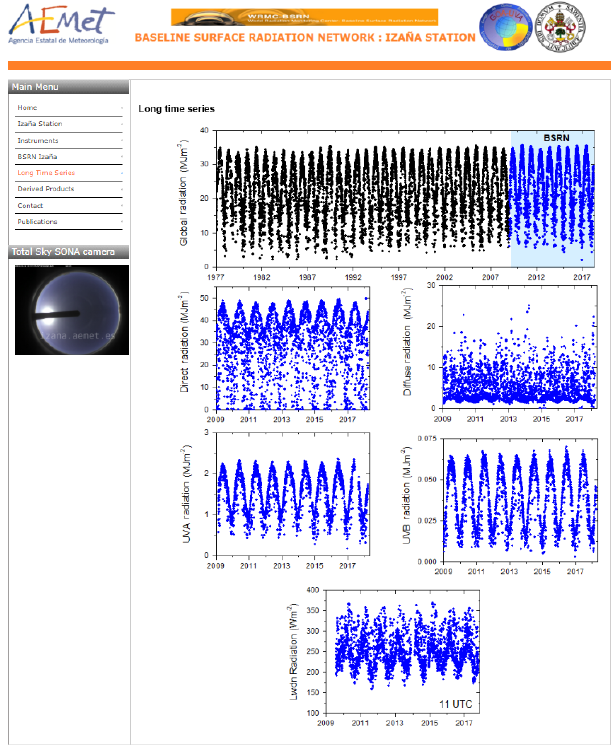
Figure 13. IZA time series of daily SWD, DIR, DIF, UV-A and UV- B measurements, and instantaneous LWD data series (11:00UTC) for the period 2009–2017.